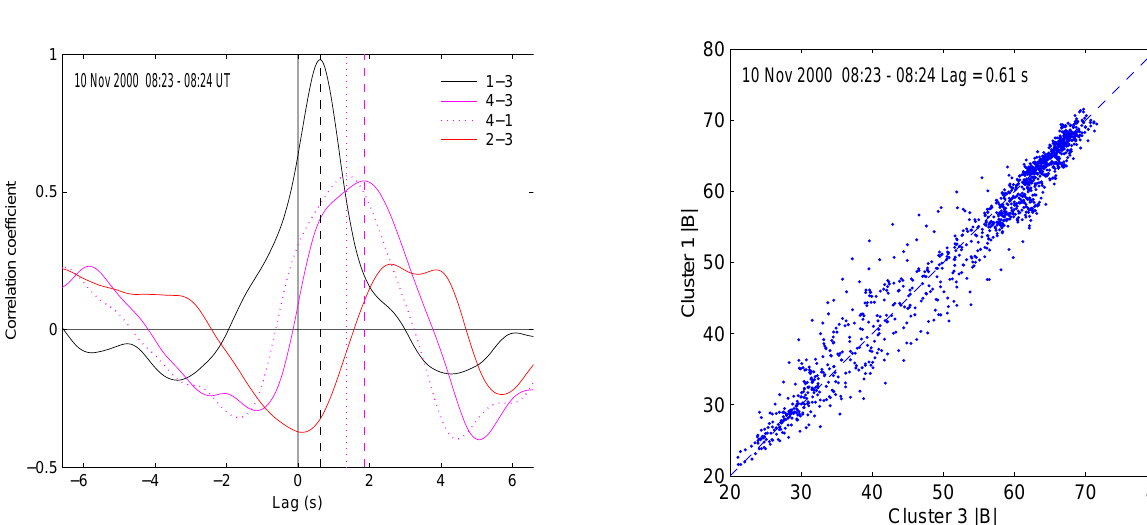
Fig. 8. A scatter plot of the magnetic field magnitude measured at Cluster 1 plotted against that measured at Cluster 3, at a time delay of 0.61s, which corresponds to the peak of the cross-correlation